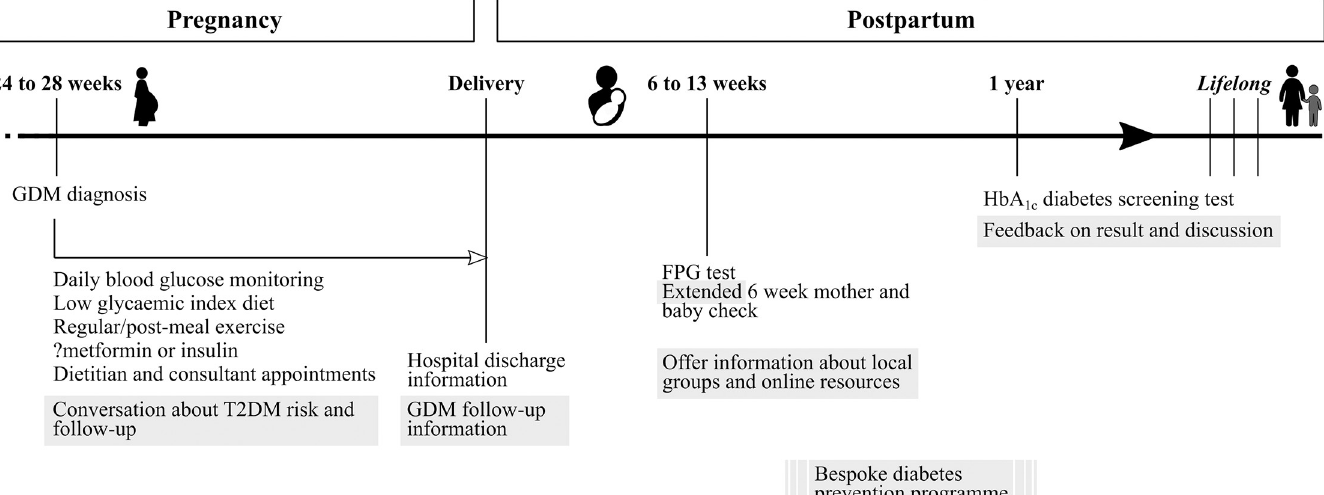
PLOS ONE | https://doi.org/10.1371/journal.pone.0262852 January 21,